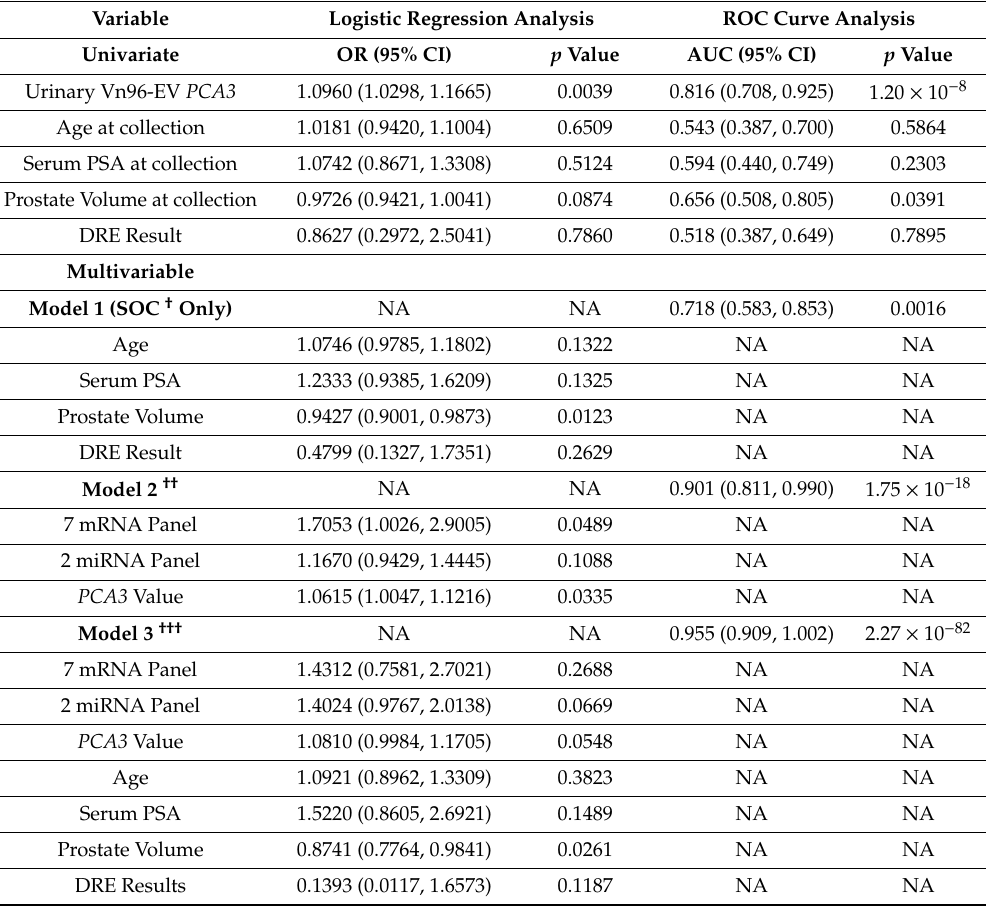
Table 5. Performance of multivariable models combining urinary Vn96-isolated EV mRNAs and miRNAs with clinical characteristics for prostate cancer prediction and